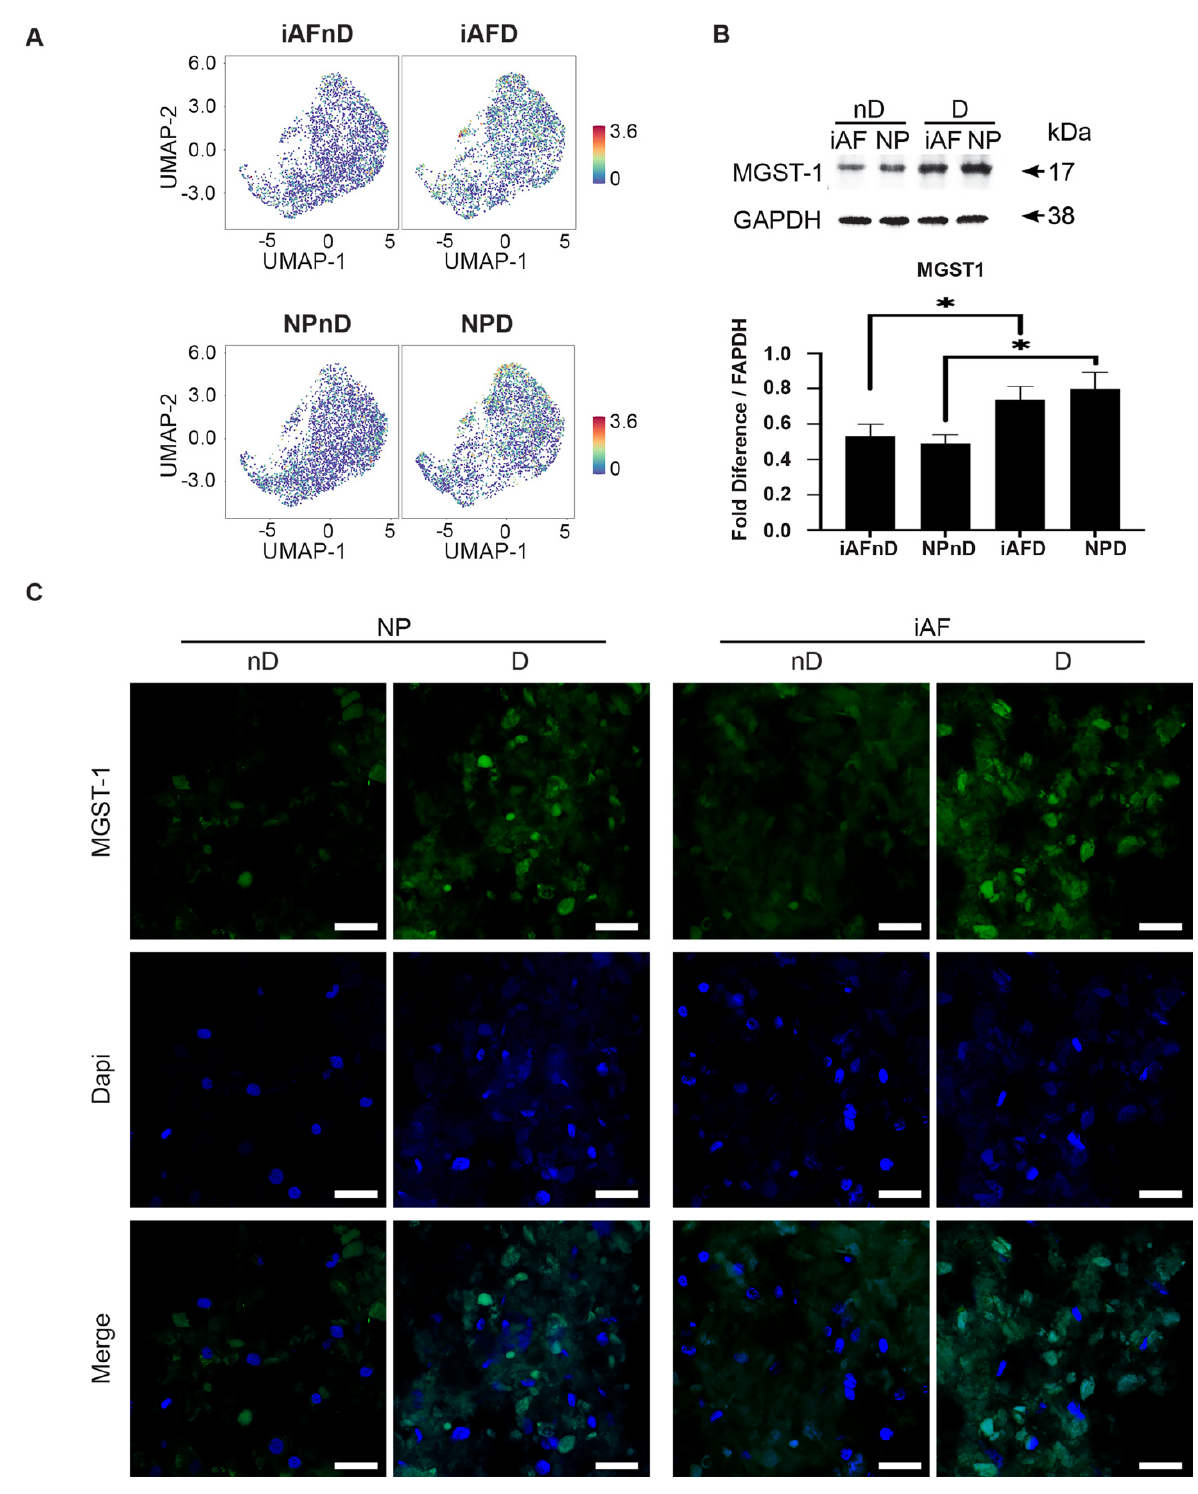
Figure 10. Validation of selected cell type and degeneration markers. ( A ) UMAP highlighting MGST-1 gene expression at the single cell level in iAF and NP nD and D discs of the same individual. ( B ) Western Blot analysis of cell lysates from 5 additional individuals normalized to GAPDH (n = 5). ( C ) Immunohistochemistry staining of MGST-1 (in green), Dapi (in blue) and merged images of cells from 5 additional individuals (scale = 100 µm, n = 5 biological replicates). Graphs are presented as mean ± SEM. * p < 0.05